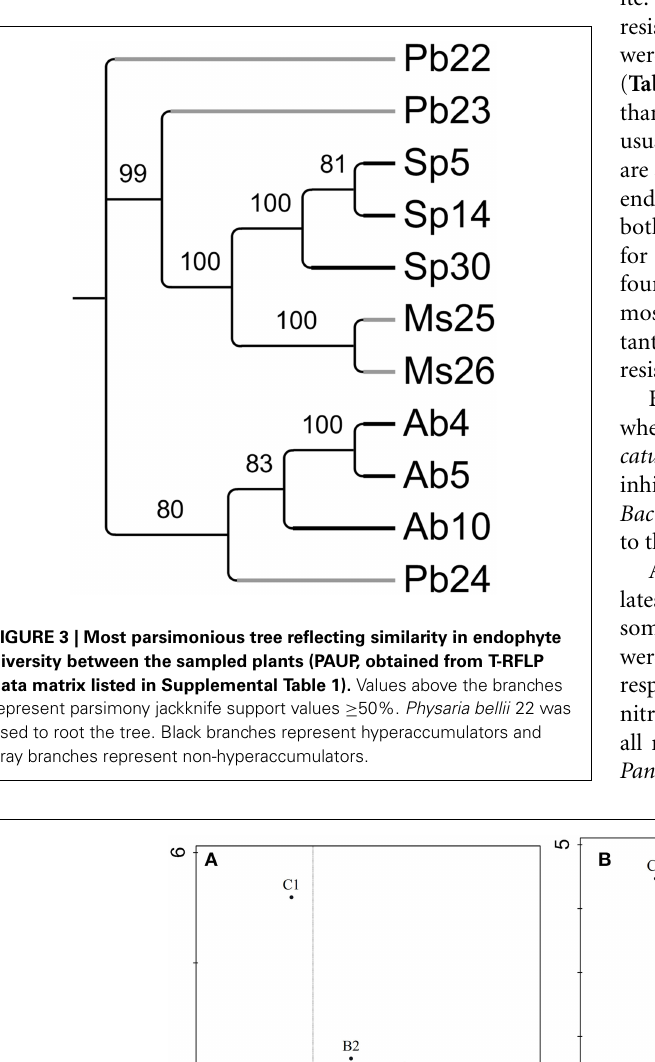
from leaves) and characteristics by small black circles. A1 (cocci), A2 (rods), B1 (Gram-positive), B2 (Gram-negative), C1 (yellow), C2 (yellowish), C3 (creamy), C4 (white), D1 (colonies getting brown with time), D2 (colonies do not get brown with time), E1 (circular colony form), E2 (irregular form), F1 (entire margin), F2 (undulate margin), G1 (flat colony), G2 (raised colony), H1 (smooth), H2 (rough), I1 (shiny), I2 (dry), J1 (punctiform), J2 (regular